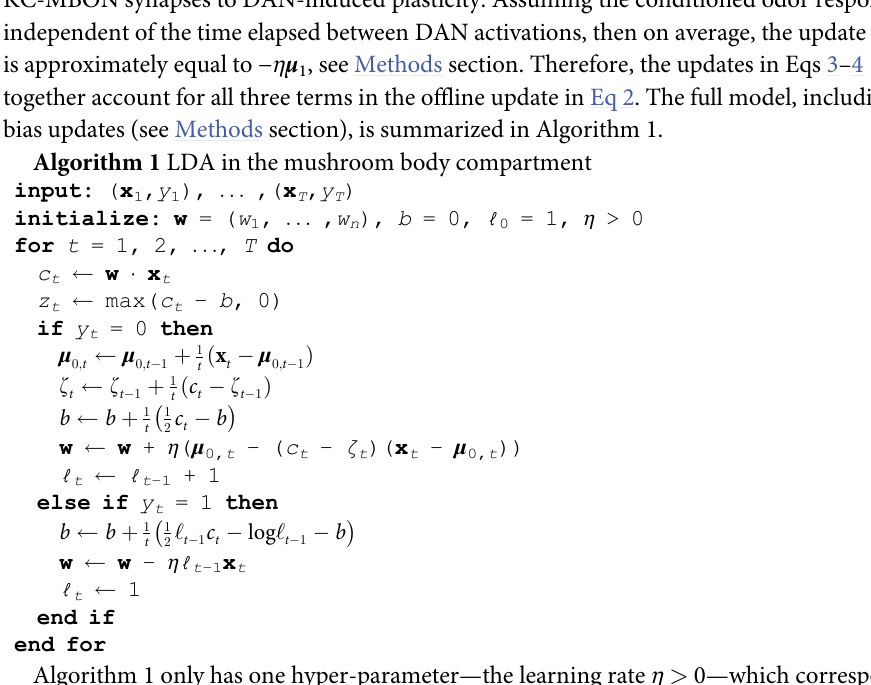
Algorithm 1 only has one hyper-parameter—the learning rate η > 0—which corresponds to timescale for learning in the mushroom body compartment. Hige et al. [5] showed that mushroom body compartments have distinct timescales for learning, which can be modeled by choosing different learning rates η >